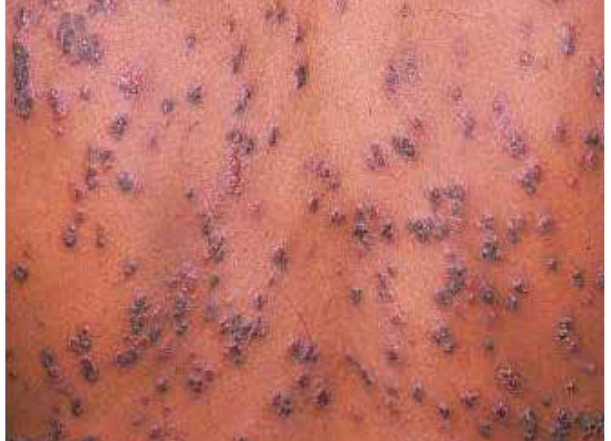
Figure 9. Papulo-pruritic eruption of HIV. Note the extensive excoriations and post inflammatory hyperpigmentation